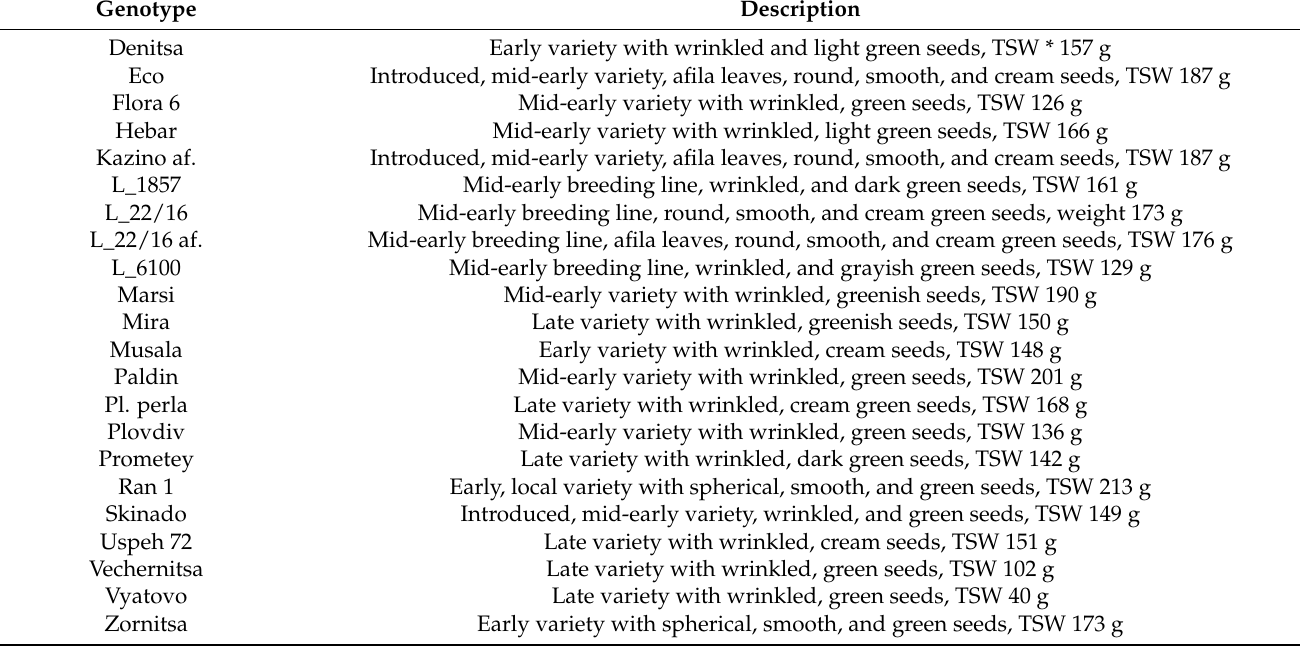
Table 1. Description of plant material used in the